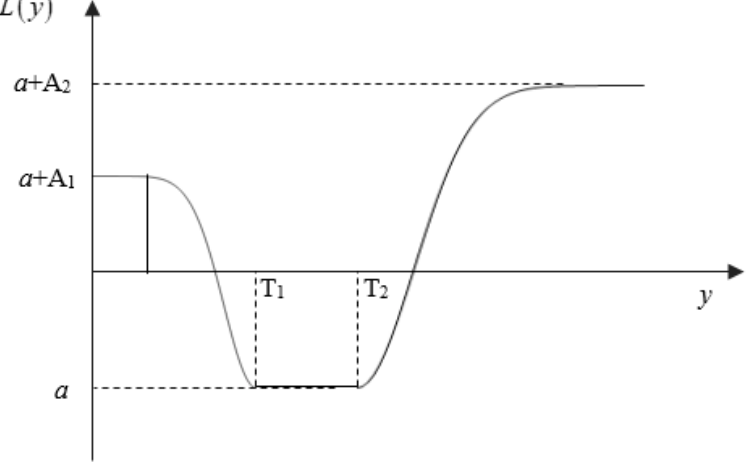
Figure 1. Curve of constant compensation.